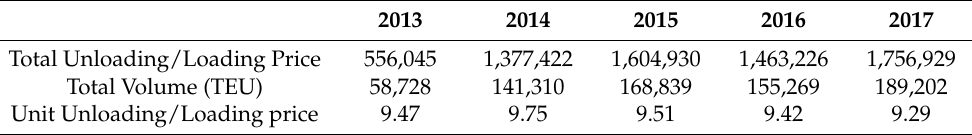
Table 4. Average unit unloading price per year (unit: U.S. dollars).